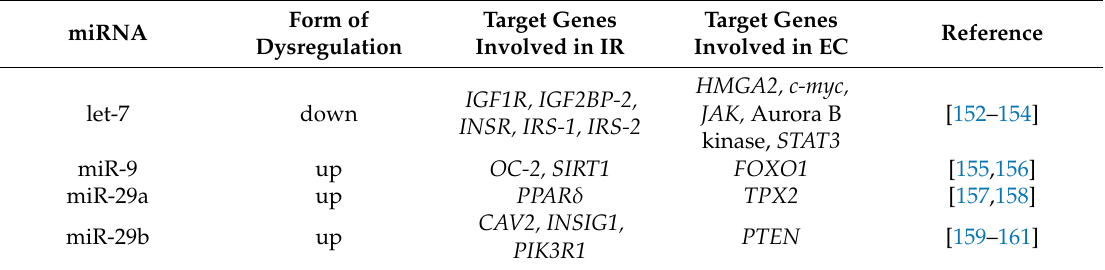
Table 3. miRNAs found as dysregulated in both insulin resistance (IR) and